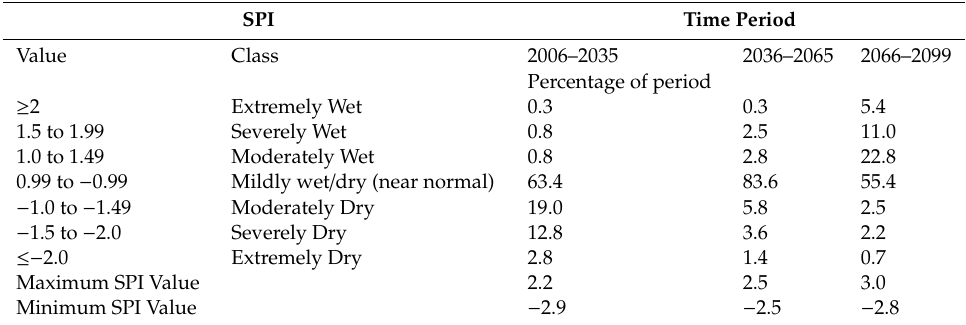
Figure 16. CanESM2 3-month period SPI values for Gulu for the duration 2006–2099. Table 11. Percentage variation of SPI values for Gulu over the period 2006–2099. Table 9. Percentage variation of Standardized Precipitation Index (SPI) values for Kaabong over the period 2006–2099.